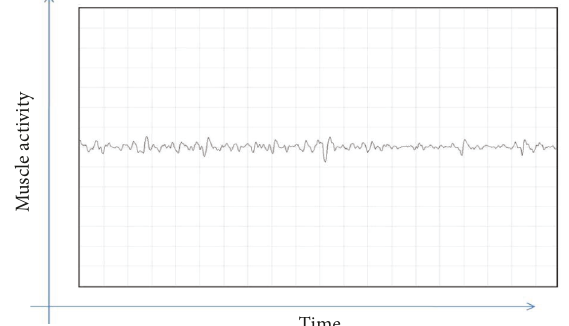
Figure 1: Electromyography recording of a healthy individual before treatment.